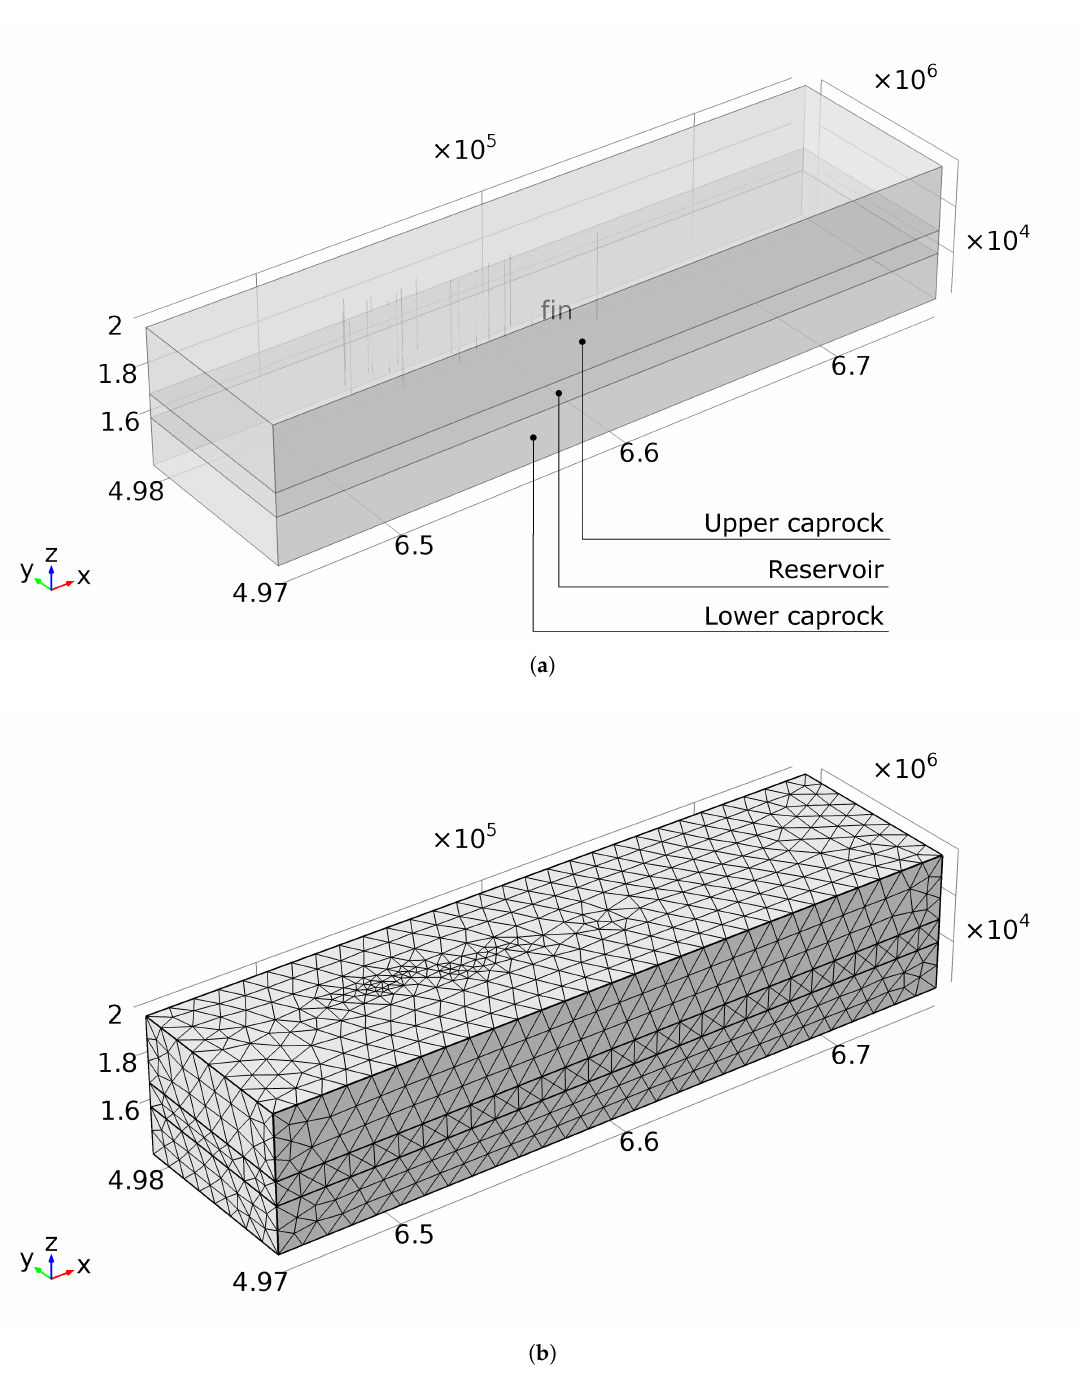
Figure 3. Cavone oilfield modeling—geometry ( a ) and mesh ( b ) of the three layers reservoir model, with dimensions in